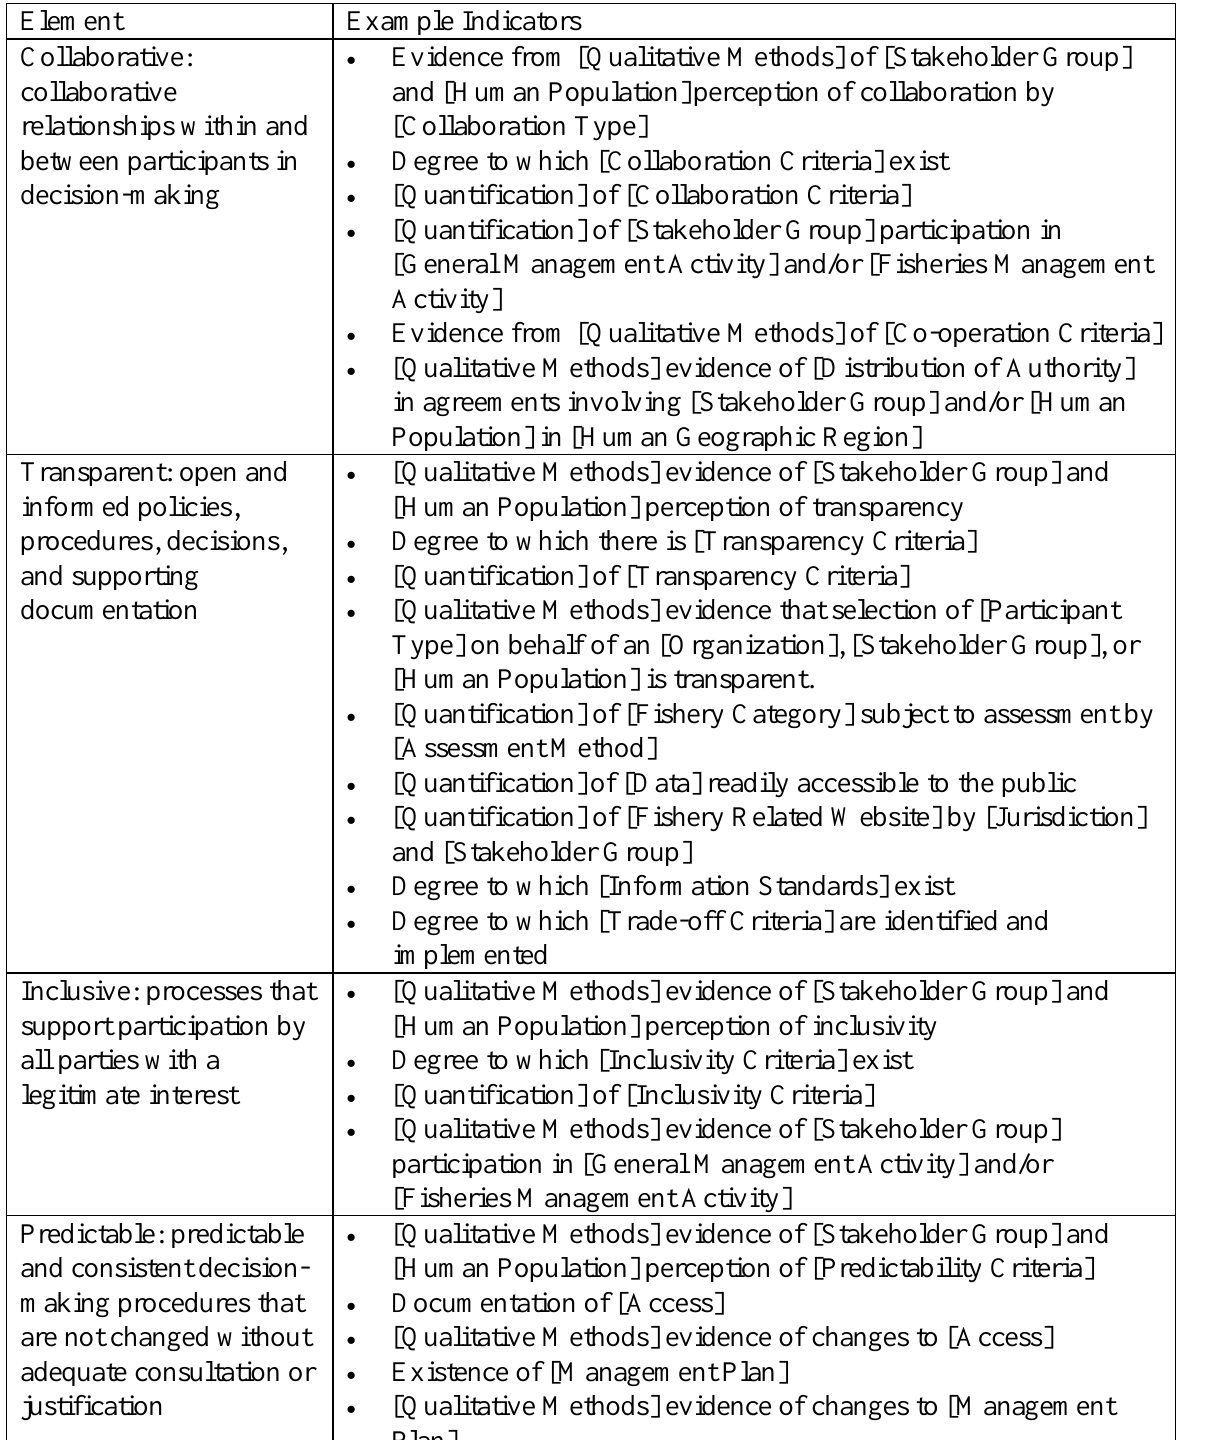
Table A1.2: Decision-making Process Dimension – Example Indicators